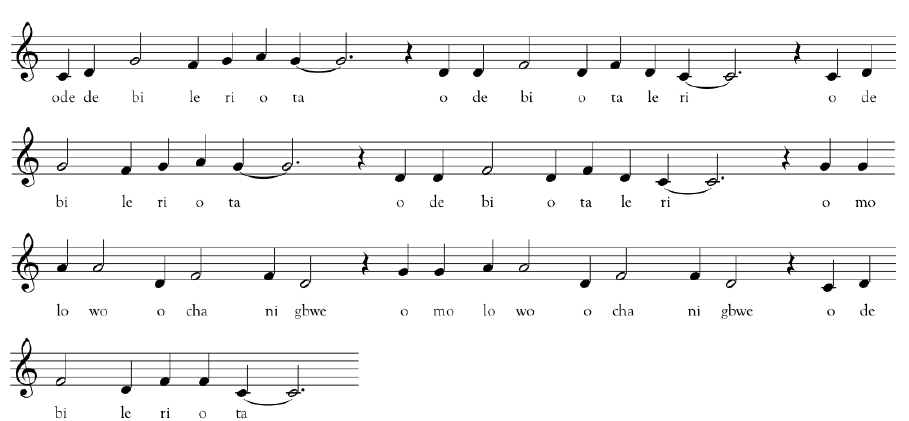
Figure 3. Sketch of the melody of García’s composition for “Odebi, el cazador” (Odebi, The Hunter).